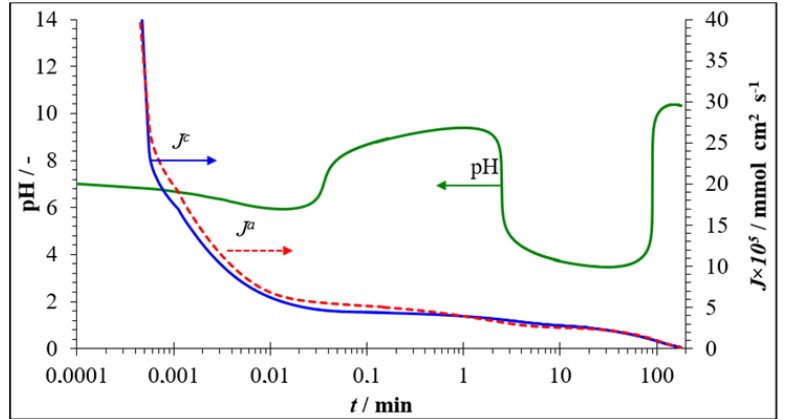
Figure 18. Calculated (using the non-steady state model time dependences of the saline solution pH and fluxes through the CEM ( J c ) and the AEM ( J a ) which were in H + and OH − forms, respectively, before the beginning of the ND process. Adapted from [15].